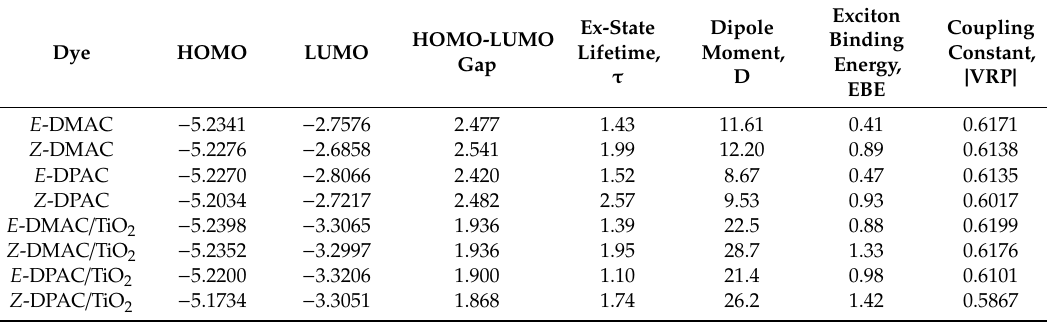
Table 3. HOMO and LUMO energy values and energy gaps, excited state lifetimes, dipole moments, exciton binding energies, and coupling constants of the isolated dyes and dye / TiO 2